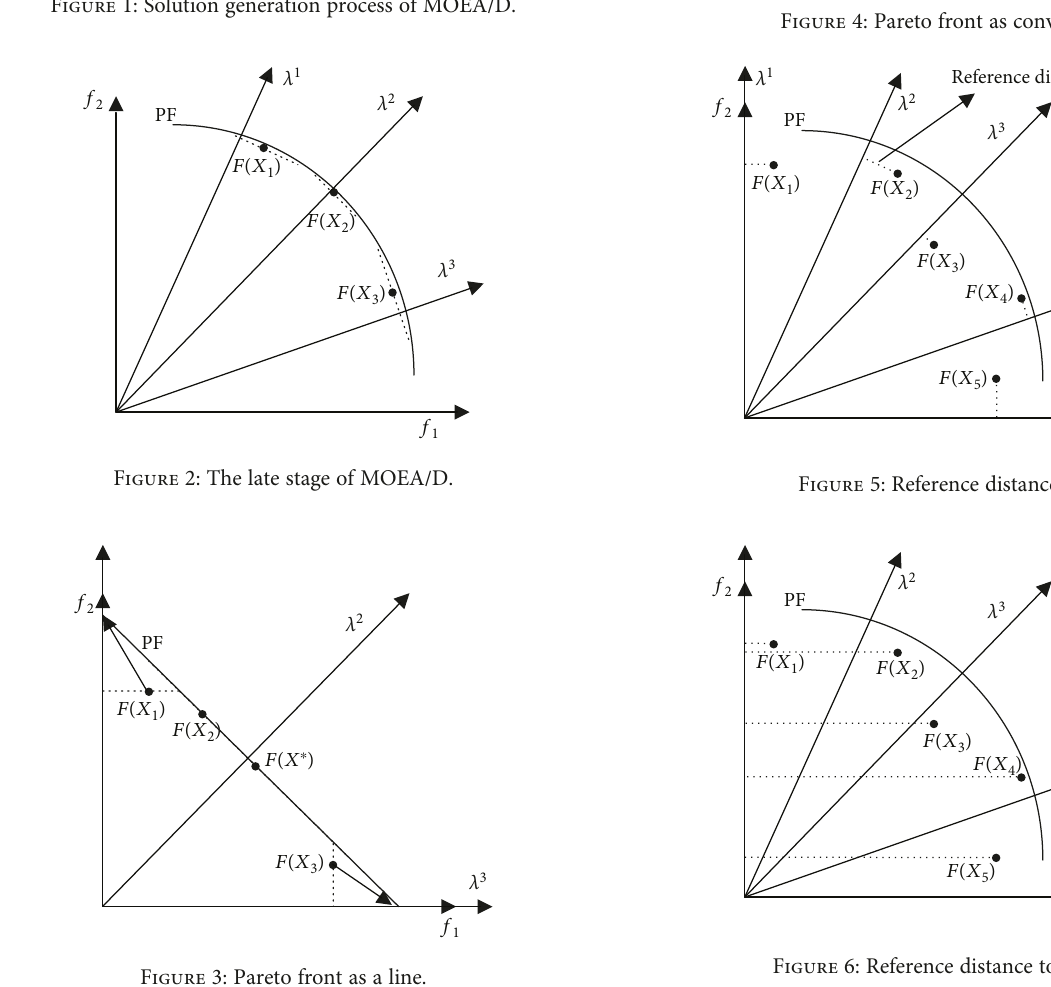
Figure 4: Pareto front as convex.